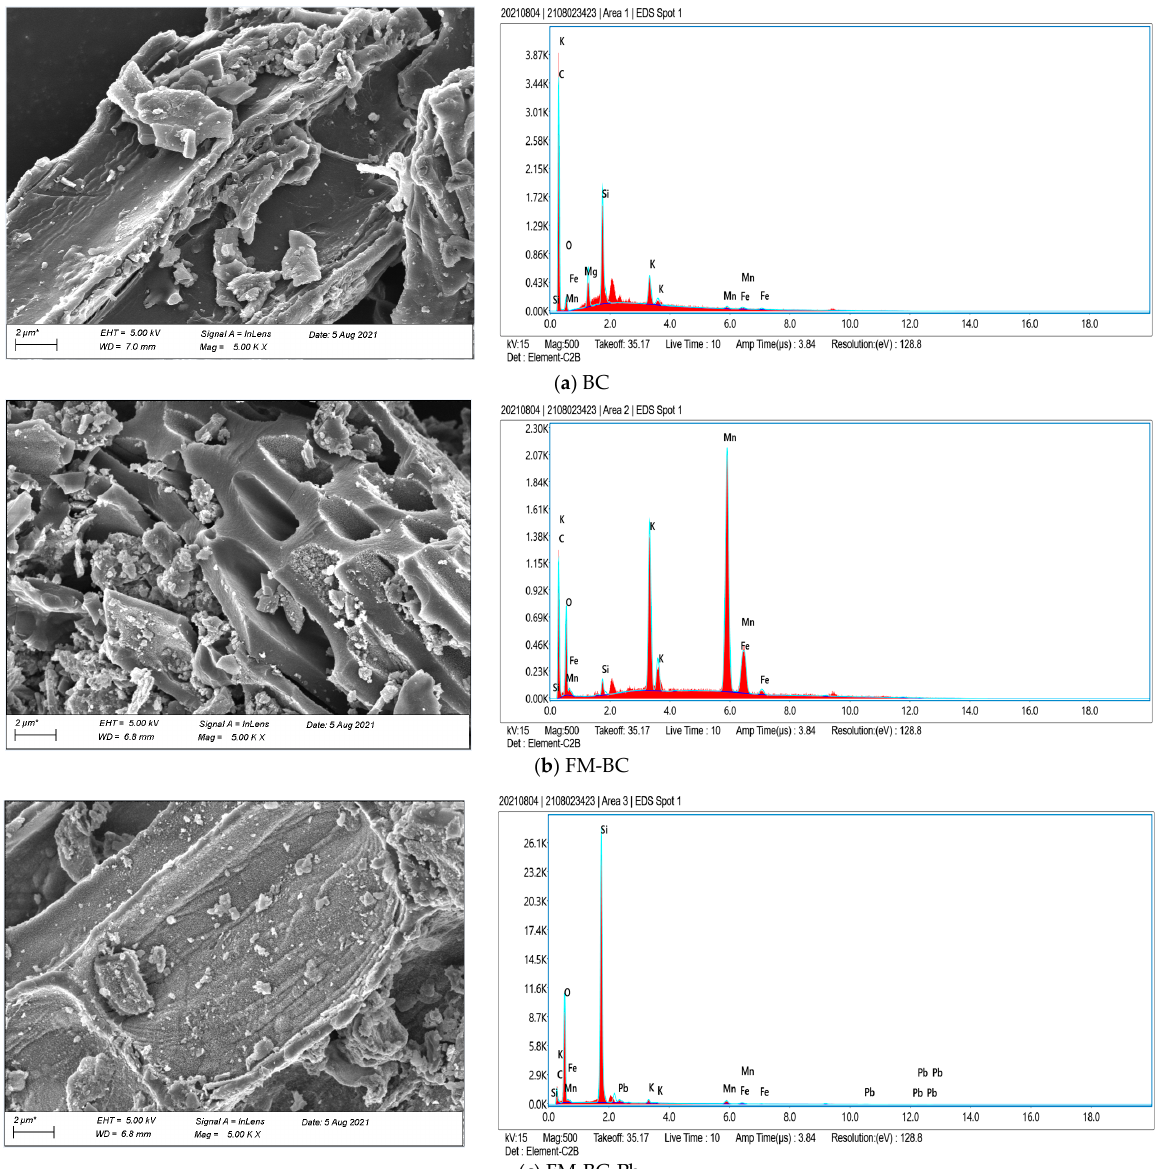
Figure 1. SEM-EDS images of ( a ) rice straw biochar (BC), ( b ) Fe-Mn oxide biochar (FM-BC), and ( c ) Fe-Mn oxide biochar after adsorption of Pb(II) Table 1. Surface property parameters of biochar.